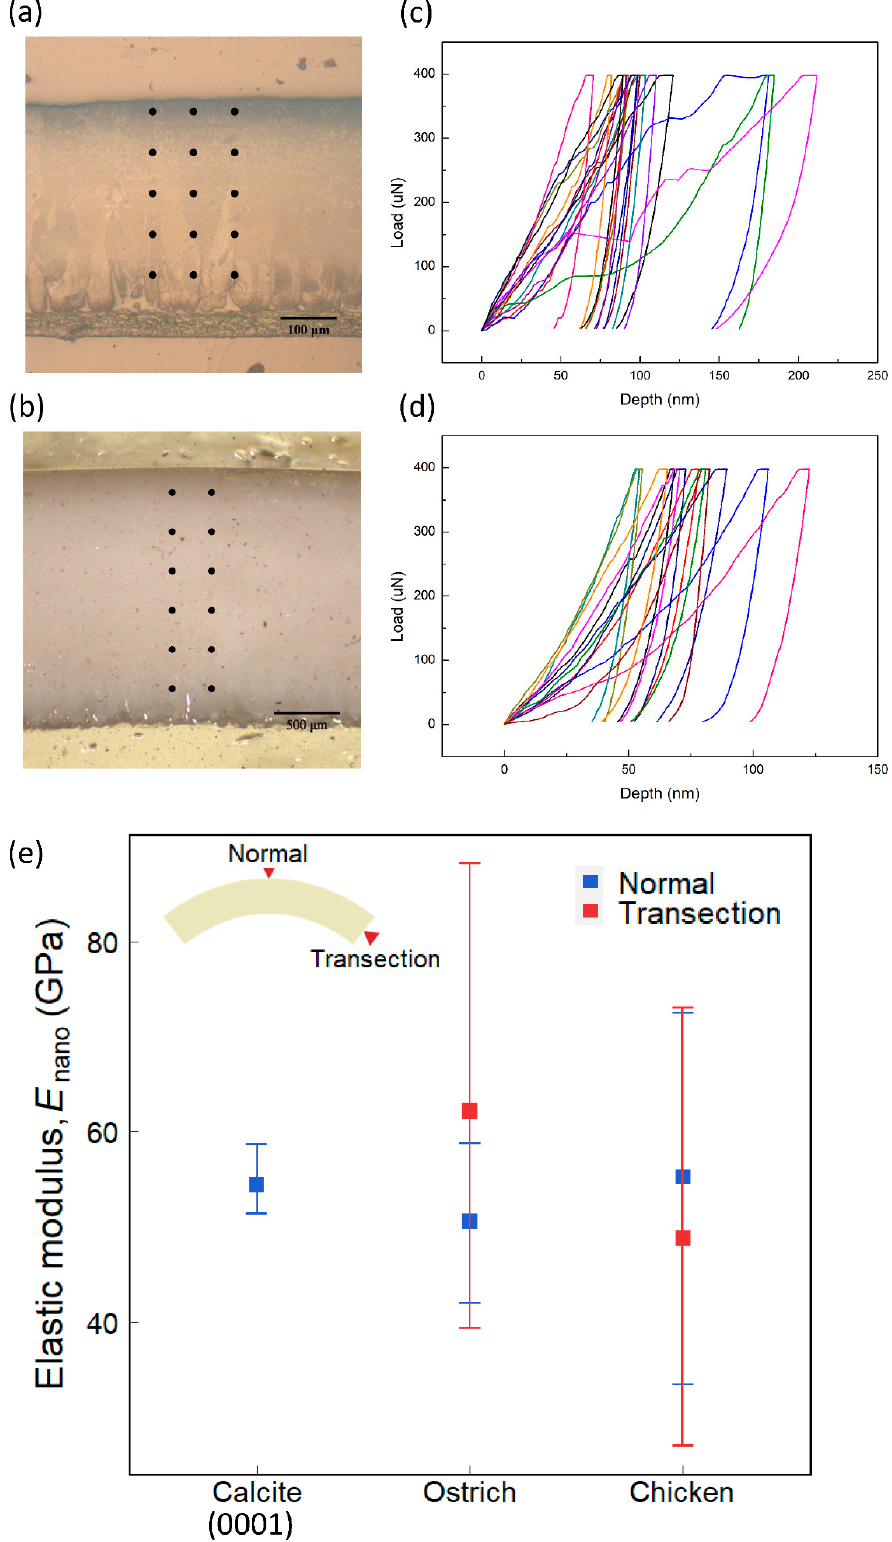
Figure 5. The test points in the transection direction of ( a ) chicken and ( b ) ostrich. The load–depth curves of nanoindentation on those test points for ( c ) chicken and ( d ) ostrich. ( e ) The results of nanoindentation test. The blue represents the normal direction (calcite: n = 4, ostrich: n = 12, chicken: n = 21). The red represents the transection direction (ostrich: n = 12, chicken: n = 11). The error bars are the intraspecific maximum and minimum values. The eggshell inset indicates the directions of the nanoindentation